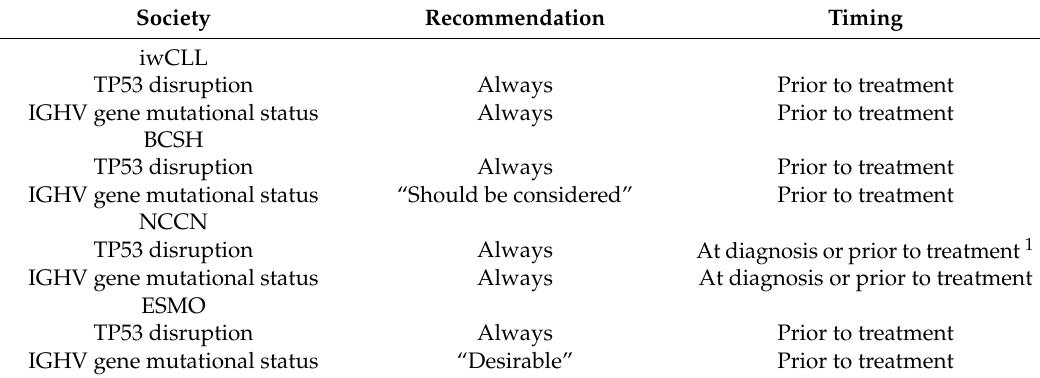
Table 2. Guideline recommendations for TP53 and IGHV analysis in clinical